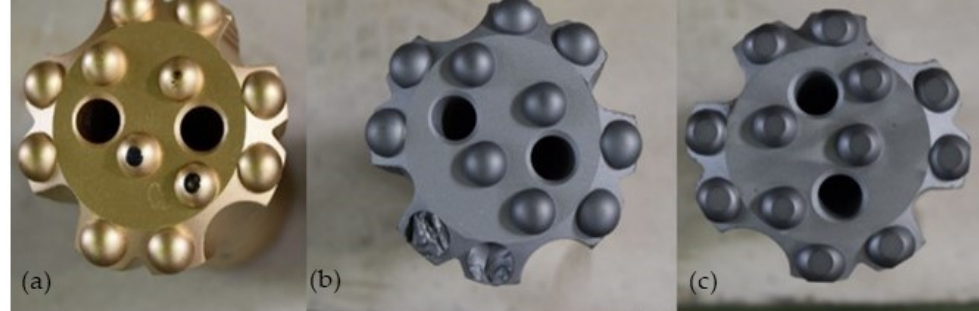
Figure 2. Tungsten carbide drill bits used for drilling: ( a ) normal bit, ( b ) chipped button bit (defective), ( c ) worn-out bit (abrasion).